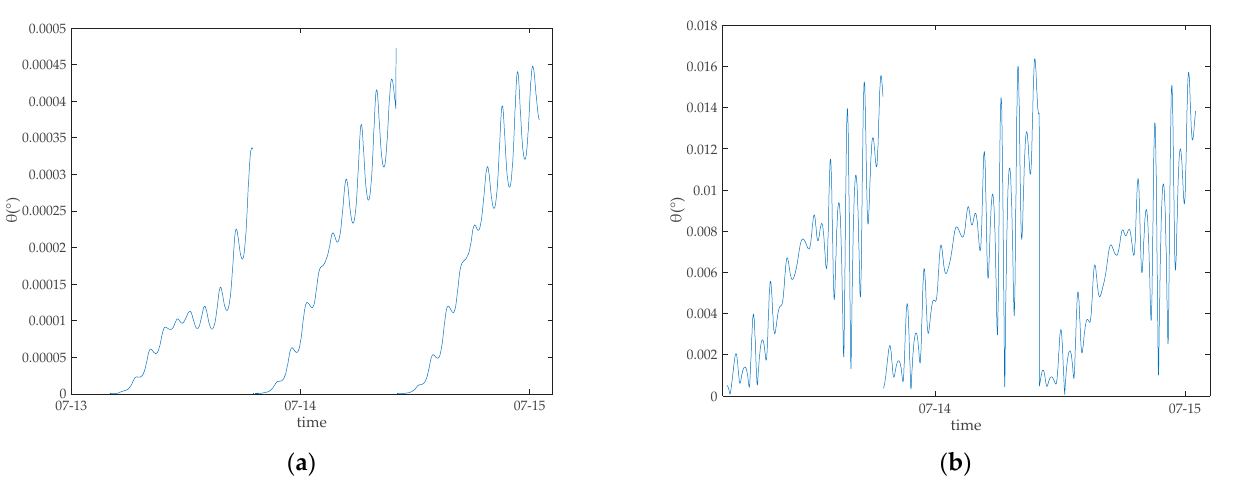
Figure 10. Variation of pointing error angle caused by satellite orbit perturbation with time: ( a ) uplink terahertz communication link for LEO-GEO; ( b ) downlink terahertz communication link for GEO-LEO.